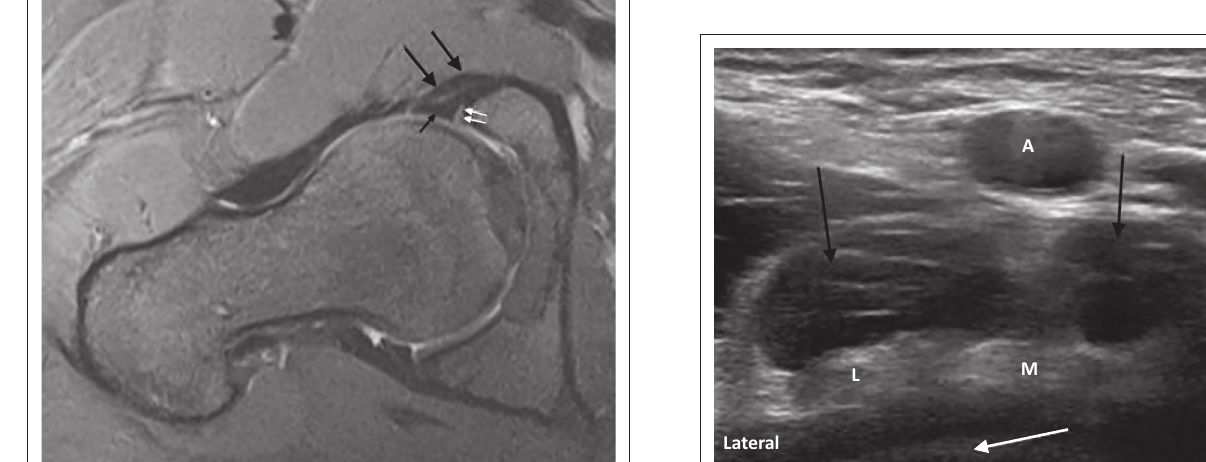
FIGURE 3: Axial ultrasound image with the patient beginning to return to neutral from the frog-leg position. The medial psoas tendon component (M) lies anterolateral to the lateral component (L). The iliopsoas muscle (long black arrows) and femoral head (long white arrow) are shown on this image just below the acetabular rim.